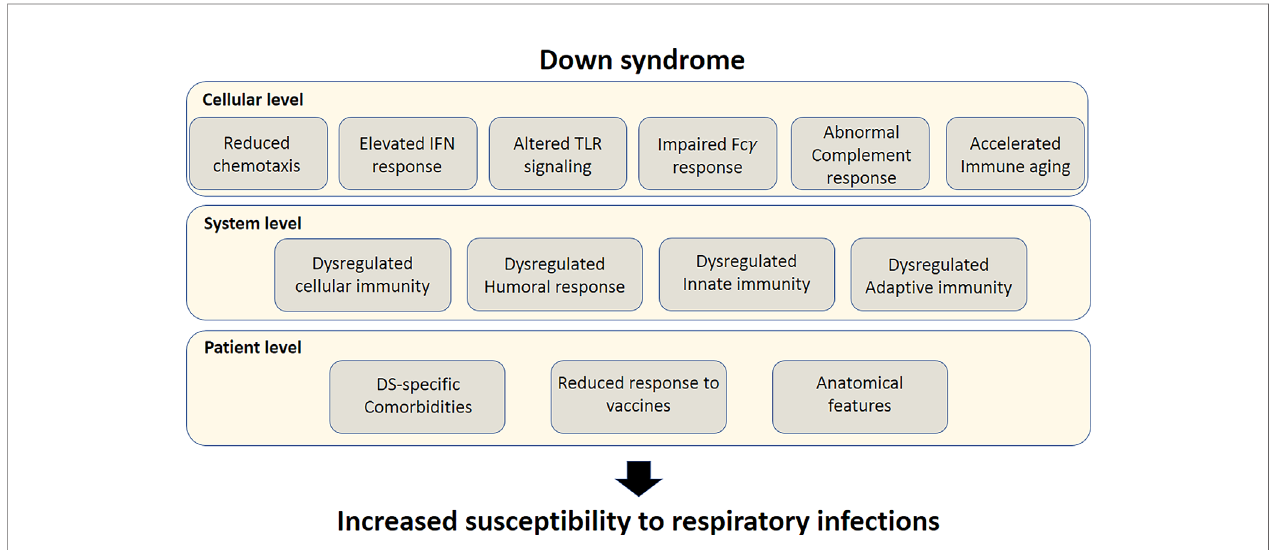
FIGURE 1 | Susceptibility factors to severe response to respiratory tract infections in Down syndrome. Top bar; Cellular-level susceptibility factors. Middle bar; System-level susceptibility factors. Lower bar; patient-level susceptibility factors. All these factors culminate in increased susceptibility of individuals with DS to respiratory tract